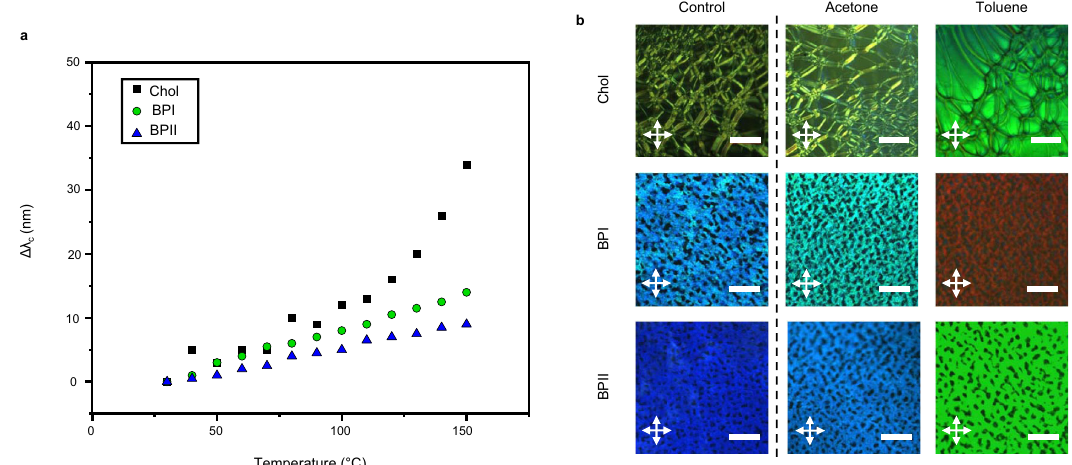
Fig. 6 Optical response to chemical swelling and heat. a Selective re fl ection band wavelength of CLCE, BPI LCE, and BPII LCE as the samples are heated from room temperature to 150 °C. b Polarized optical micrograph textures observed in re fl ection mode of CLCE, BPI LCE, and BPII LCE (scale bar 100 μ m) in response to swelling of organic